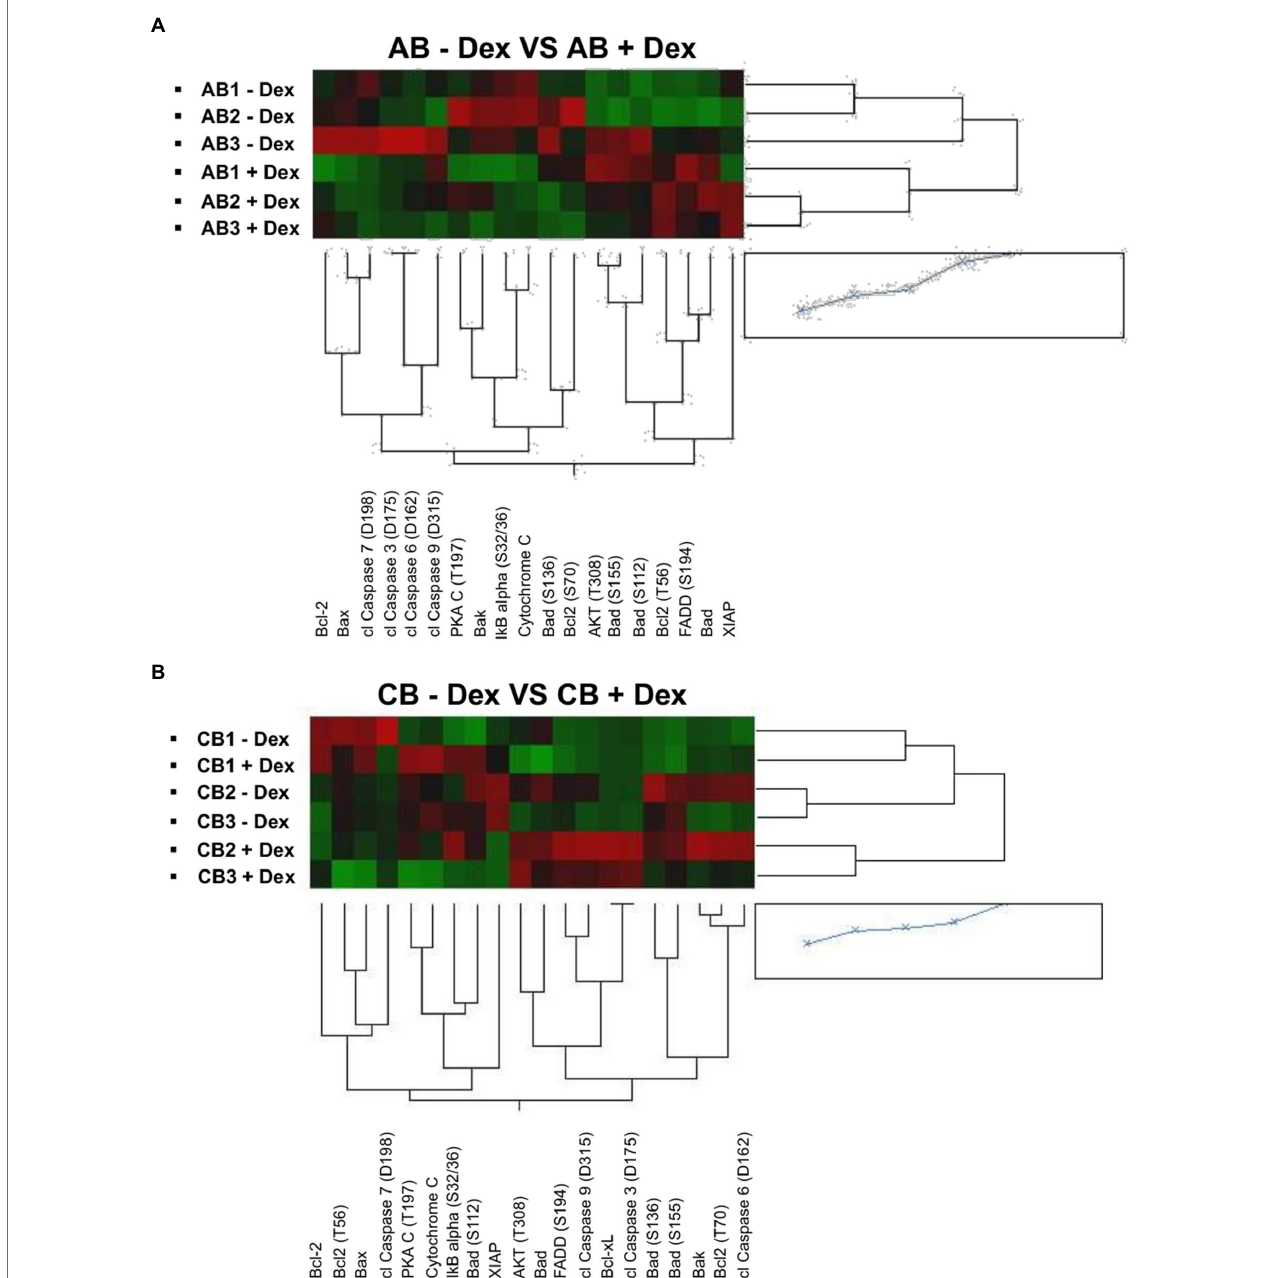
FIGURE 2 | Dex activates the pro-apoptotic signal in cells from adult blood but not in those from cord blood. Heatmaps comparing reverse-phase protein array (RPPA) analysis of protein lysates of erythroid cells from the three adult blood (A) and three cord blood donors ( B ; identified with the same code used in Figure 1